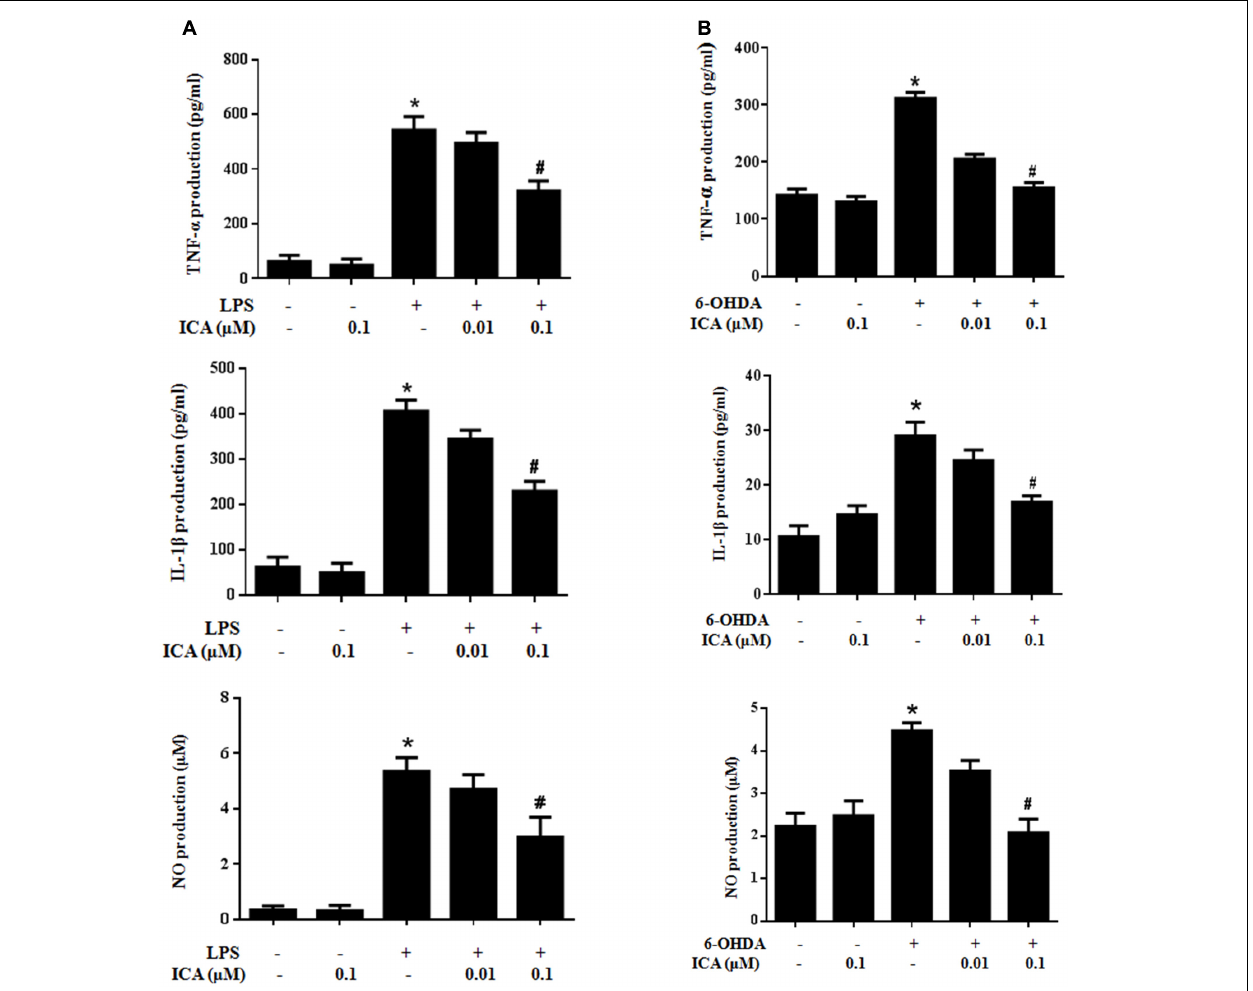
FIGURE 5 | Icariin inhibited LPS-/6-OHDA-induced release of pro-inflammatory factors in vitro . Primary midbrain neuron-glia cultures were treated with ICA (0.01 and 0.1 µ M) for 30 min followed by LPS (A) or 6-OHDA (B) treatment. Twenty-four h later, the release of TNF- α , IL-1 β , and NO in the culture medium was detected by ELISA and Griess regent, respectively. Results were the mean ± SEM from three independent experiments performed in triplicate. ∗ p < 0.05 compared with the control cultures; # p < 0.05 compared with LPS-/6-OHDA treated